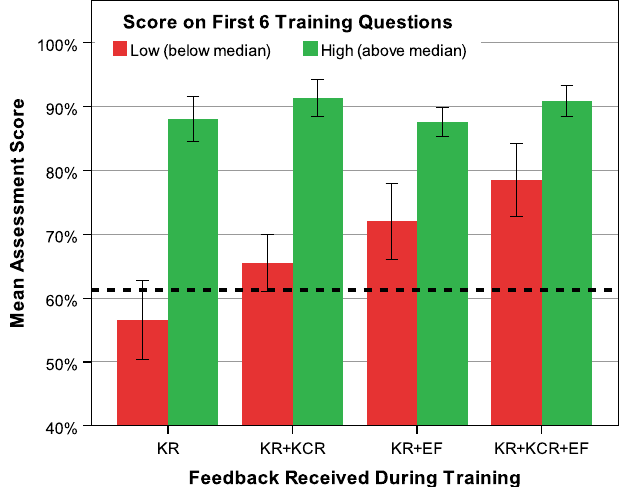
FIG. 7. Mean assessment scores for experiment 2 students for each training condition, split by high or low scores on the first six training questions (prescores). The dotted line represents the mean control score. with low prior knowledge [ANOVA F ð 3 Þ ¼ 2 . 85 ,